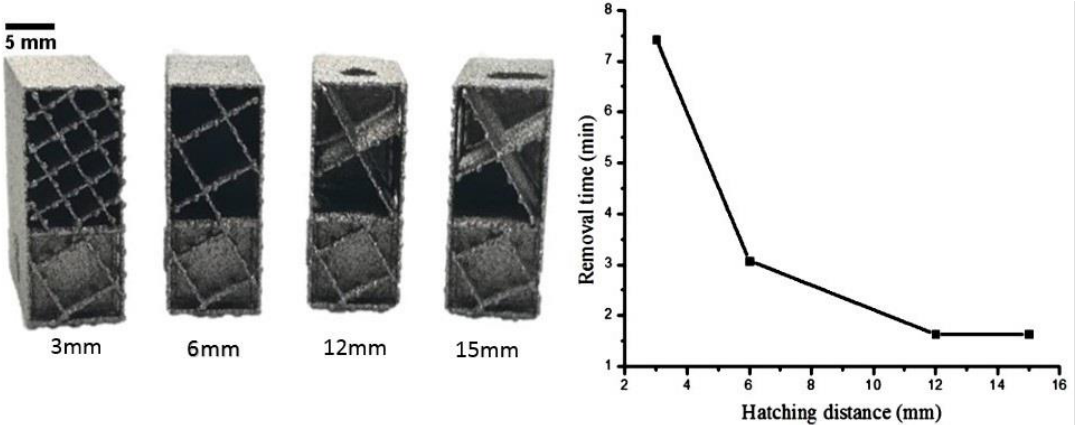
Figure 8. Effect of hatching distance on support removability.